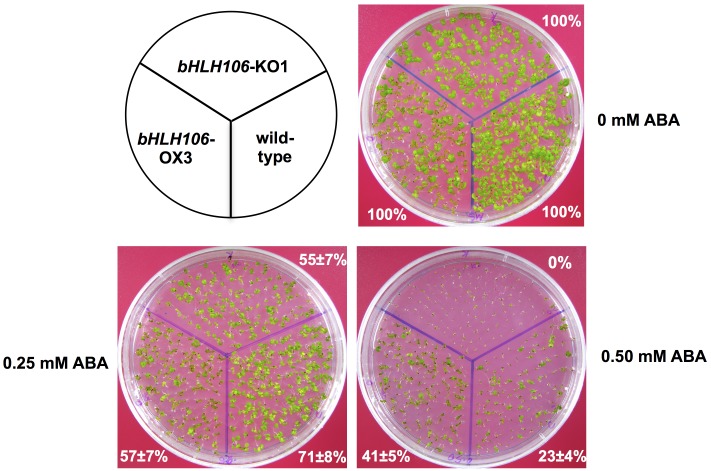
Response of bHLH106-KO and bHLH106-OX lines to ABA.
bHLH106-KO1 and bHLH106-OX3 lines were grown in medium containing different concentrations of ABA for 2 weeks. The percentages are surviving rates of employed lines in comparison with their survival on the standard MS medium without ABA.